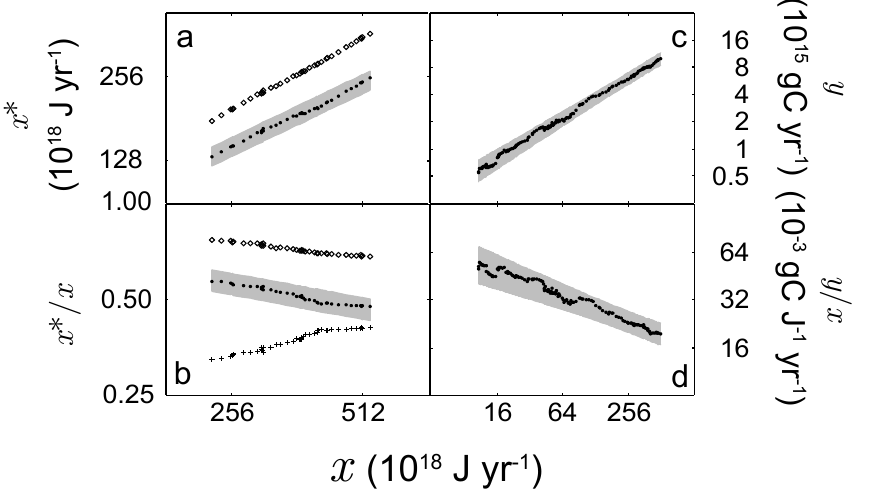
Figure 1. (a) The relationship between global primary energy use, x , and global final energy, x ∗ . Two definitions of final energy are shown; (o) are the IEA estimates, ( • ) are the IEA estimates adjusted for energy used for transport, agriculture, forestry, mining and quarrying. (b) The relationship between global primary energy use, x , and primary to final network efficiency, defined as the ratio x ∗ /x ( are the estimated variations in end-use efficiency assuming a total system efficiency 10% ( + ). The IEA definition of primary to final energy efficiencies (o) are also shown for reference. (c) The relationship between global primary energy use, x , and global anthropogenic CO 2 emissions, y , for the data shown in Fig. 3. (d) The relationship between global primary energy use, x , and the carbon intensity of global primary energy, x/y again for the data shown in Fig. 3. The bands for all plots represent 5th to 95th uncertainty ranges from the linear regressions. See text for all data sources and